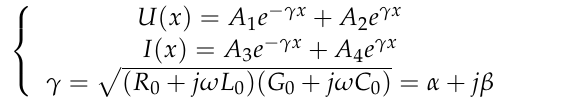
constant frequency ω is inputted at the starting point. In Figure 1, the symbol U ( x ) represents the voltage at the transmission line x relative to the reference point 0, and the unit is V. The symbol I ( x ) means the current at the transmission line x . The unit is A. Divide the transmission line into many micro-segments, dx . The symbol U ( x ) + dU ( x ) represents the voltage after dx length, and the unit is V; the symbol I ( x ) + dI ( x ) represents the current after dx length, and the unit is A. The current and voltage on the line are harmonics with a constant frequency. The symbols R 0 , L 0 , C 0 , and G 0 respectively represent the transmission line resistance, inductance, capacitance, and conductance per unit length.